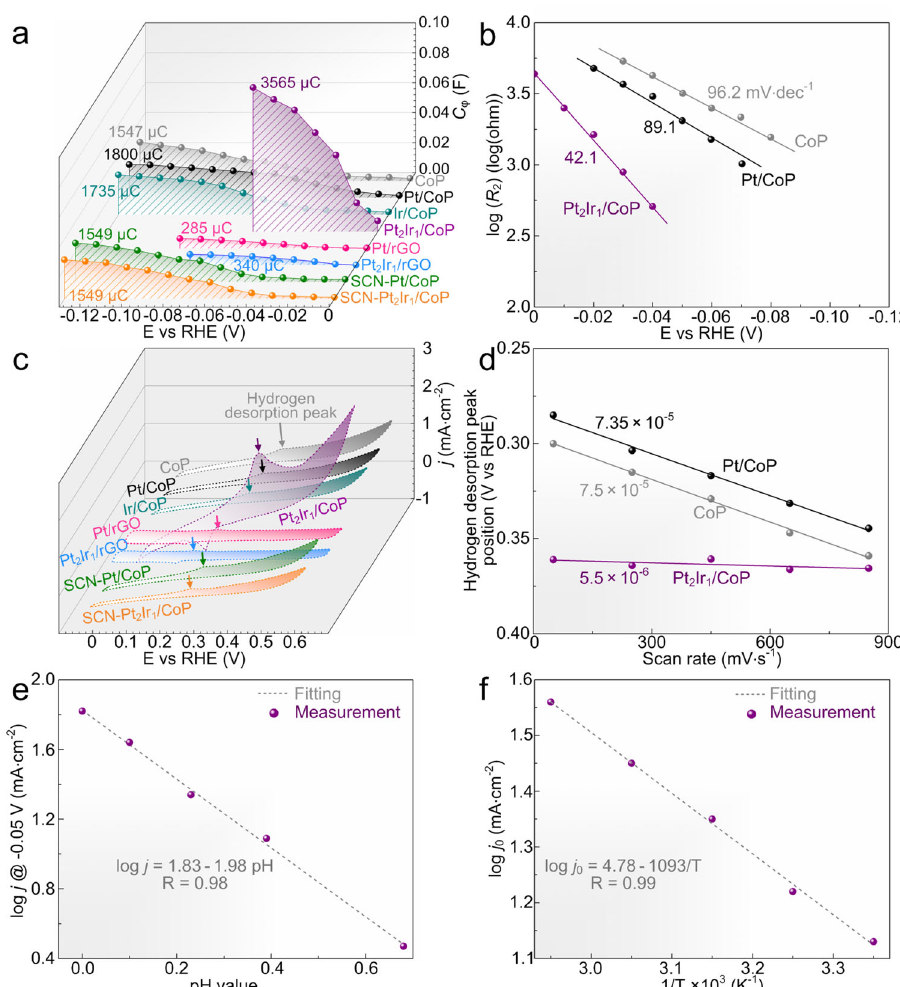
Fig. 6 Hydrogen adsorption and desorption behaviors of various catalysts. a Plots of C φ vs. η of the bare CoP, Pt/CoP, Ir/CoP, Pt 2 Ir 1 /CoP, Pt/rGO, Pt 2 Ir 1 / rGO, SCN-Pt/CoP, and Pt 2 Ir 1 /CoP catalysts during HER in 0.5 M H 2 SO 4 . b EIS-derived Tafel plots of the bare CoP, Pt/CoP and Pt 2 Ir 1 /CoP catalysts obtained from the hydrogen adsorption resistance R 2 . c CV of the bare CoP, Pt/CoP, Ir/CoP, Pt 2 Ir 1 /CoP, Pt/rGO, Pt 2 Ir 1 /rGO, SCN-Pt/CoP and SCN-Pt 2 Ir 1 / CoP catalysts in 0.5 M H 2 SO 4 with a scan rate of 50 mV/s. d Plots of hydrogen desorption peak position vs . scan rates of the bare CoP, Pt/CoP, and Pt 2 Ir 1 / CoP catalysts. e Plots of log j at − 0.05 V (vs. RHE) vs. pH for Pt 2 Ir 1 /CoP catalysts. f Typical Arrhenius plots for Pt 2 Ir 1 /CoP